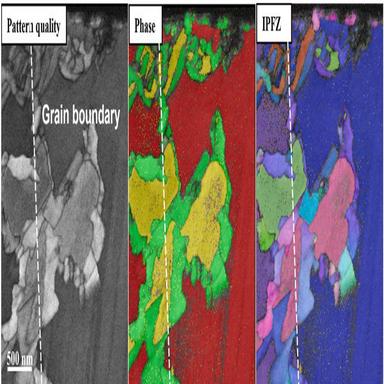
Pattern quality map, phase map, and IPFZ map (left-to-right) around a grain boundary of ZM6 alloy after oxidation for 60 h (Mg matrix in red, MgO in green, and Nd2O3 in yellow, step size = 5 nm).